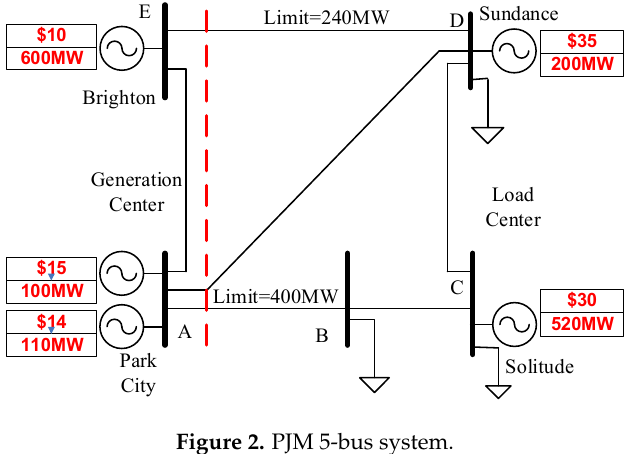
Figure 2. PJM 5 ‐ bus system. Figure 2. PJM 5-bus system. Table 1. ATC and ED results of PJM 5 ‐ bus system under different demand level. Table 1. ATC and ED results of PJM 5-bus system under different demand